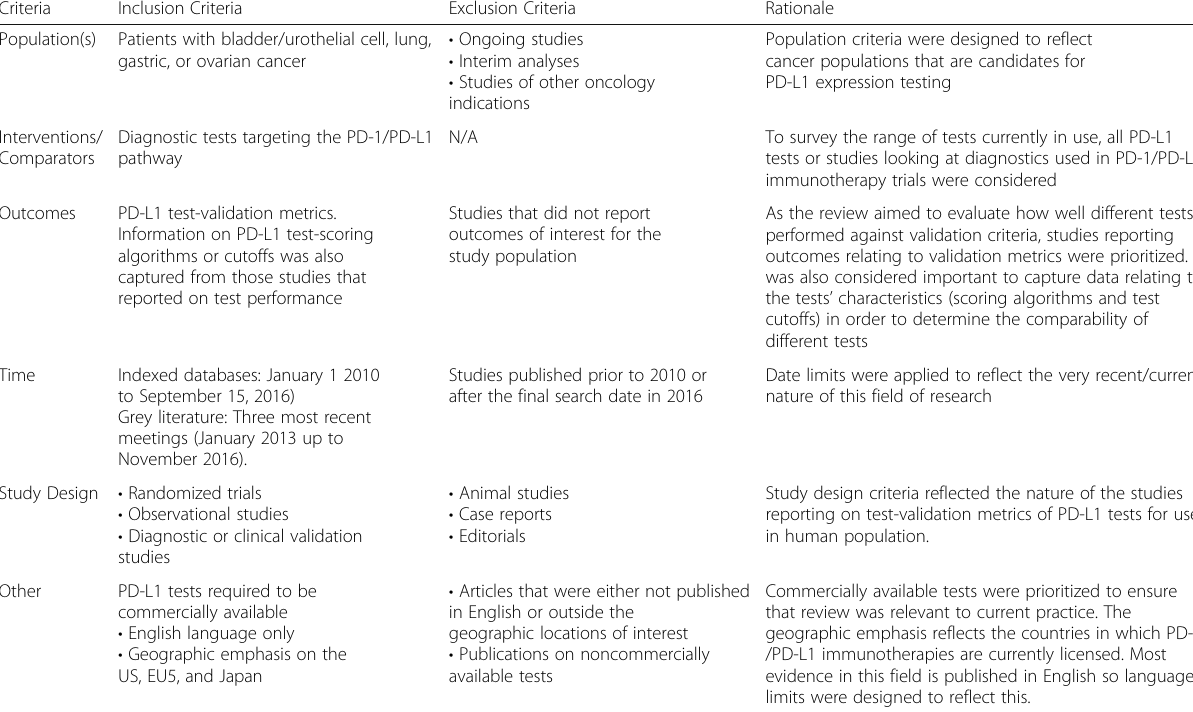
Table 1 Criteria for Study Selection